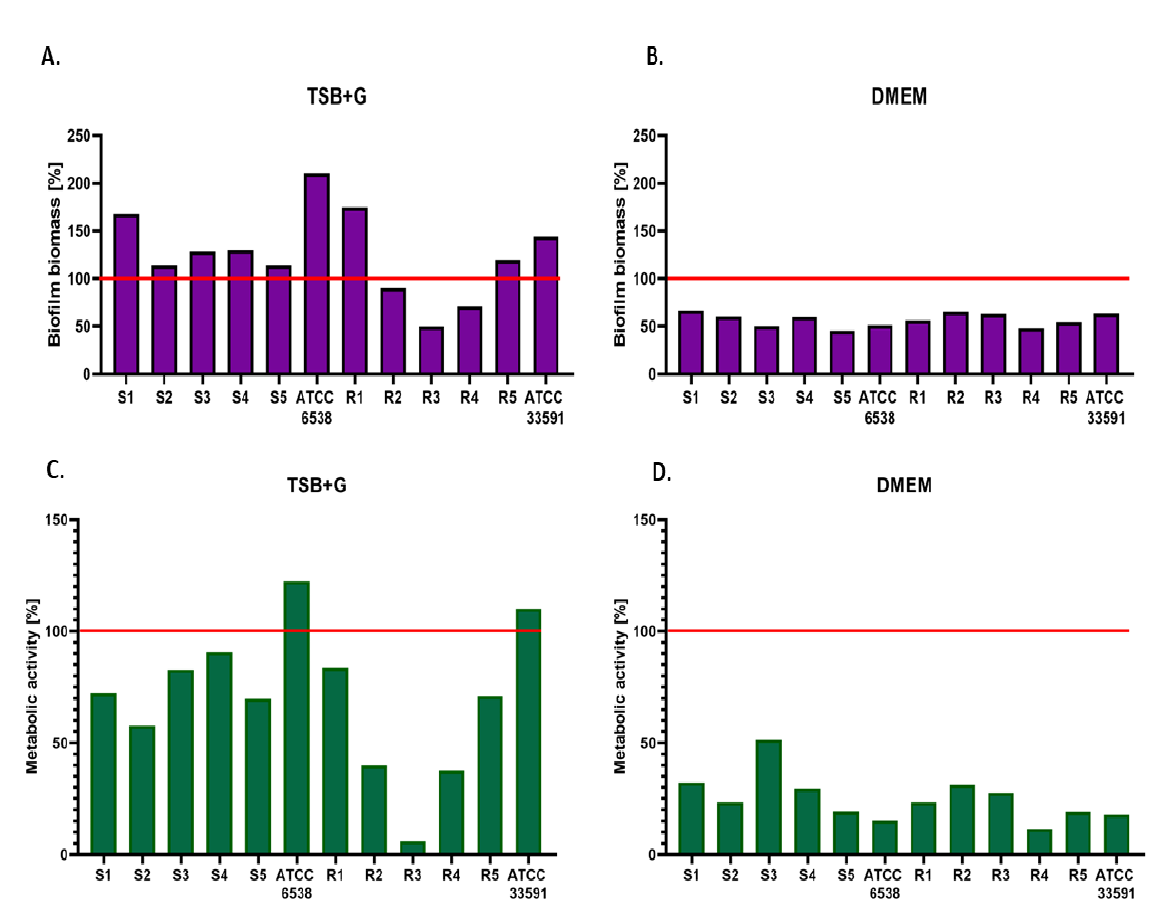
Figure 1. Comparison of the amount of biofilm biomass ( A,B ) and bacterial metabolic activity ( C , D ) between biofilms of methicillin-susceptible (S1 – S5, ATCC 6538) and methicillin-resistant Staphylo- coccus aureus (R1 – R5, ATCC 33591) formed in tryptic soy broth with 1% glucose (TSB + G) or Dul- becco ’ s Modified Eagle Medium (DMEM) with regard to results obtained for cultures in standard tryptic soy broth (TSB), which are expressed as 100% in the figure (red line); ATCC — American Type Culture Collection.